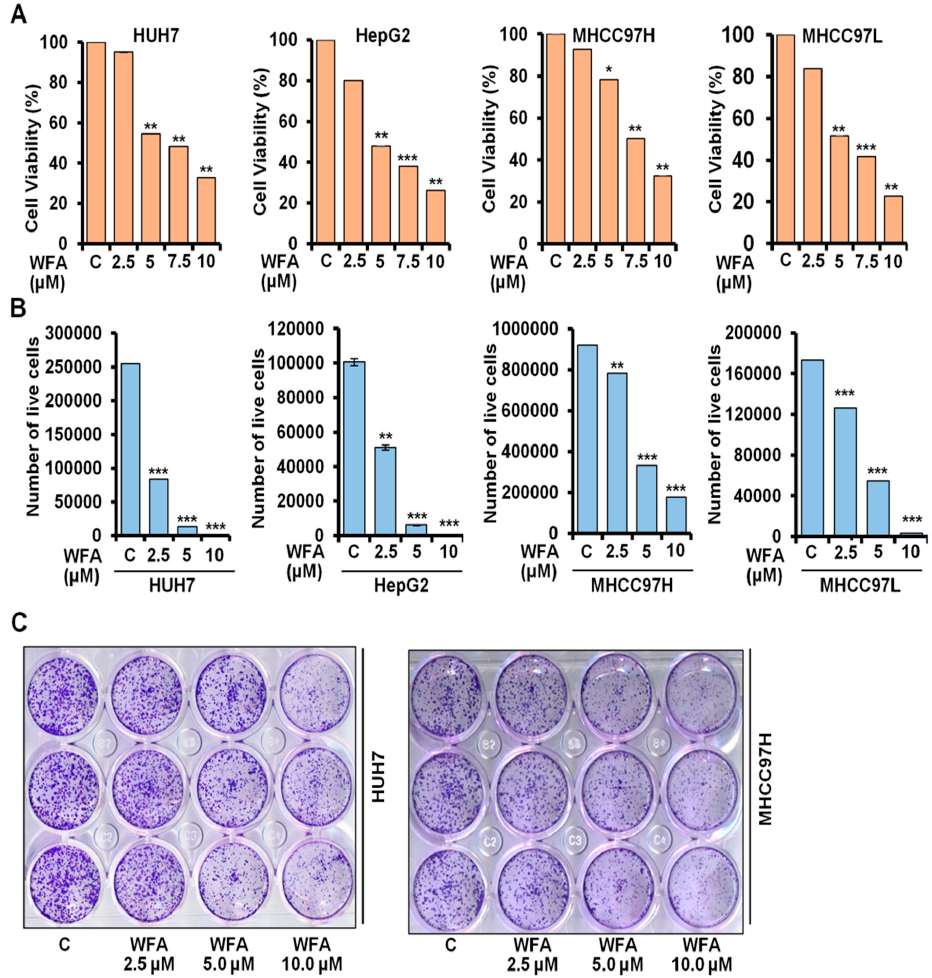
Figure 1. Withaferin A inhibits growth and clonogenicity of HCC cells. ( A ) Cell viability of Huh7, HepG2, MHCC97H and MHCC97L cells was examined using MTT assay after treatment with indicated